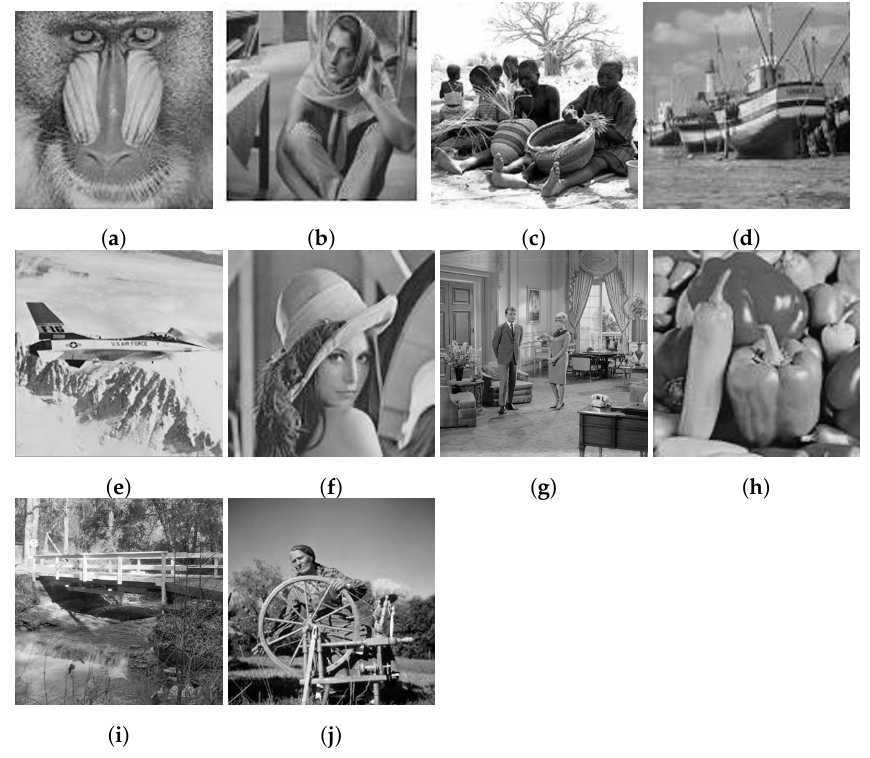
Figure 4. Cover images for the experiment ( a ) Baboon, ( b ) Barbara, ( c ) Basket, ( d ) Boat, ( e ) F16,